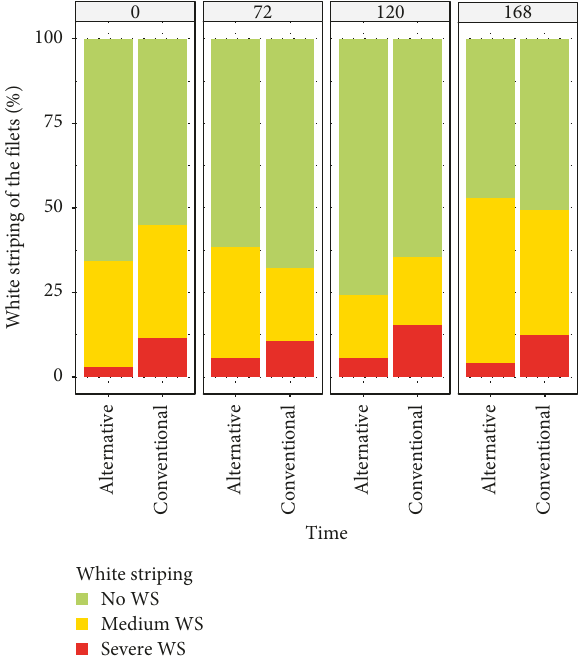
Figure 5: Purchase decision evolution during